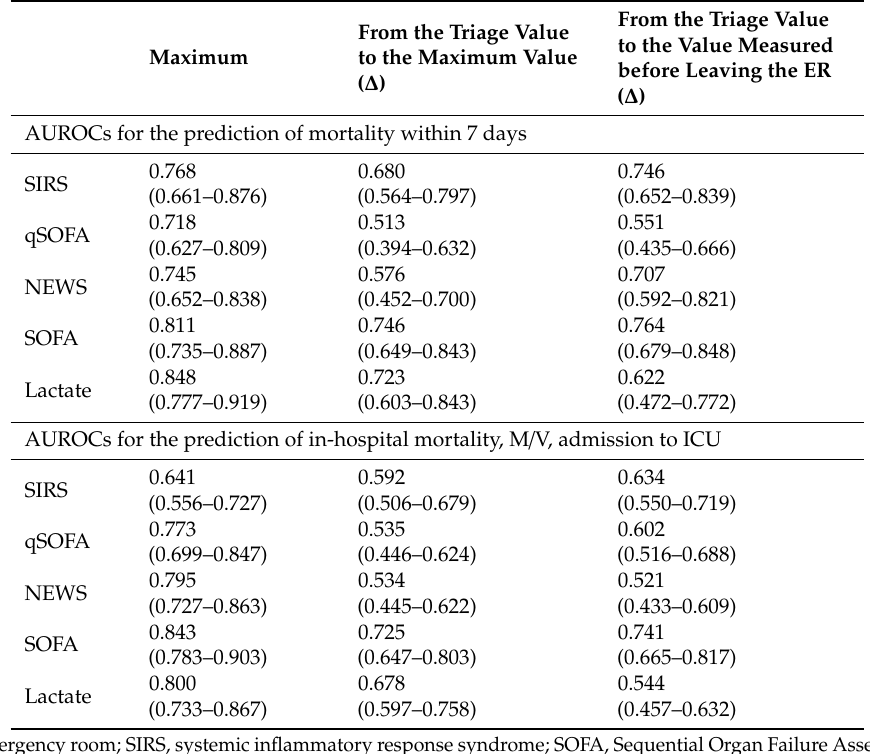
Table 3. Comparisons of areas under receiver operating characteristic curves with 95% confidence intervals for the prediction of mortality within seven days, in-hospital mortality, M / V, admission to ICU by maximum and di ff erence value of severity score.